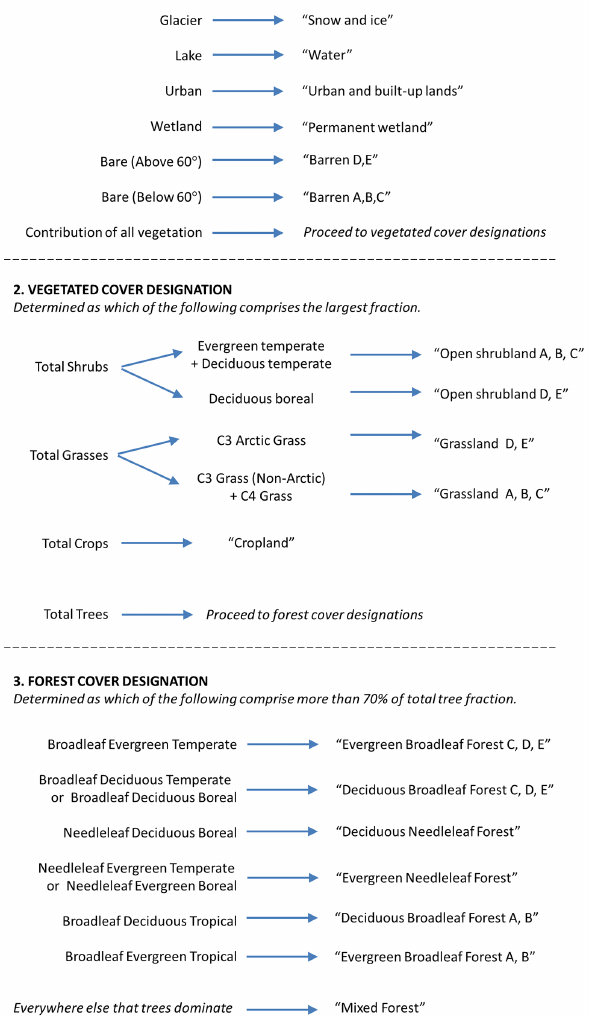
Table A1. Mapping of CLM-input land types used in the modified version of GEOS-Chem to the Wesely deposition surfaces for depo- sition, and the associated roughness (Zo) heights for each.